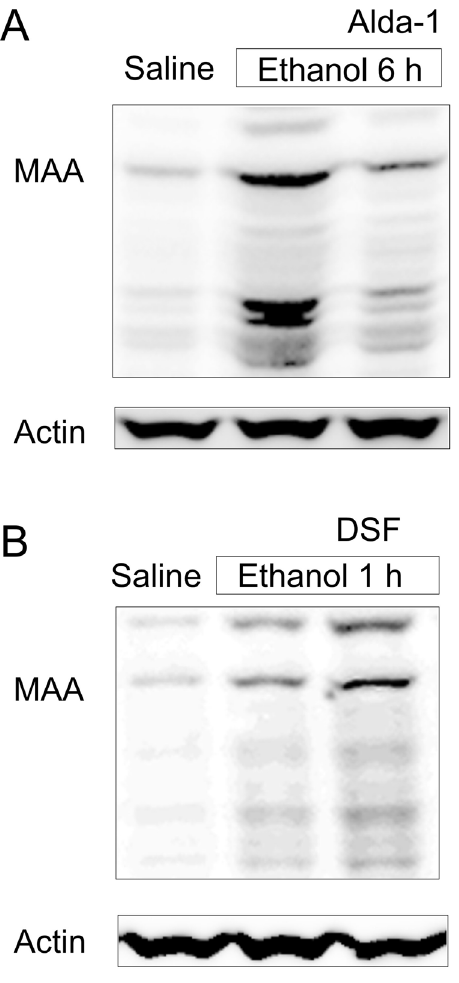
Figure 7. Alda-1 decreases whereas disulfiram increases malondialdehyde-acetaldehyde adducts after ethanol treat- ment. Mice were injected with vehicle, Alda-1 (50 mg/kg, i.p. ) or DSF (200 mg/kg, i.p. ) 30 min before gavage of saline or ethanol (6 g/kg). MAA adducts were detected in liver tissue at 6 h after ethanol treatment ( A ) or at 1 h after ethanol ( B ) by immunoblotting. Shown are representative images of gels (n=4 per group).